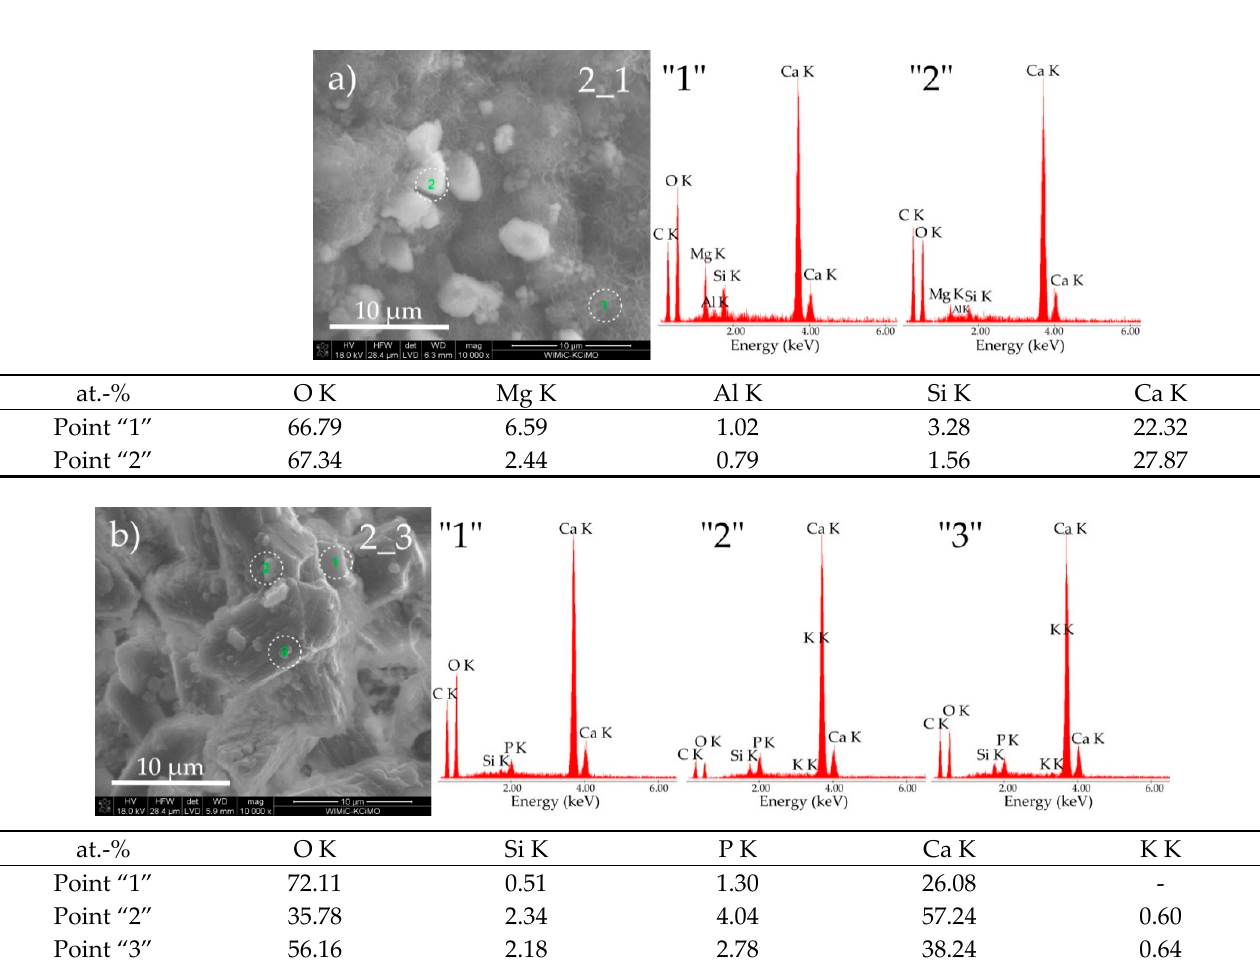
Figure 4. SEM micrographs of cement paste 2 obtained after exposure under the conditions of ( a ) water (sample 2_1) and ( b ) pig slurry (sample 2_3) with EDS quantitative point analyses from areas 1, 2, and 3.